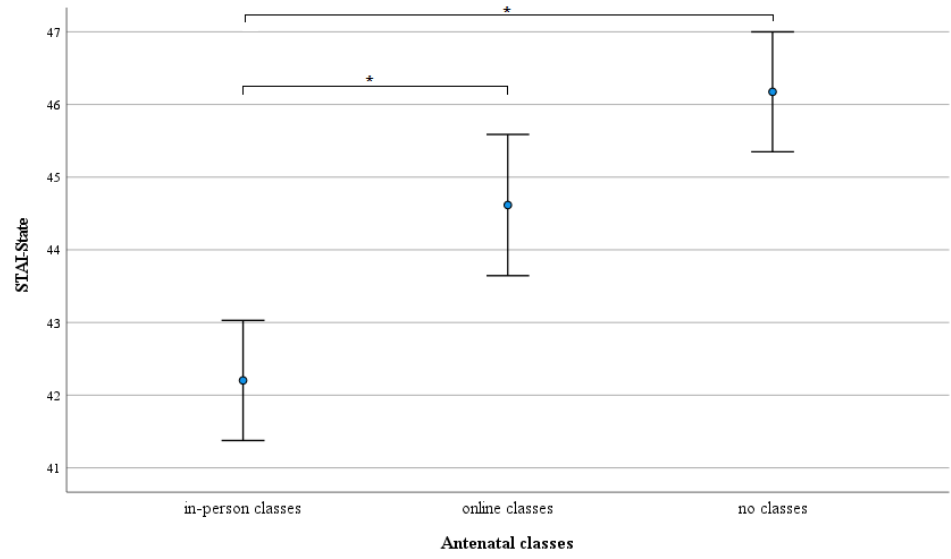
Figure 1. Differences in mean levels of state anxiety (dots) between in-person antenatal classes participants, online antenatal classes participants, and non-participants of any kind of antenatal classes adjusted for maternal age, pregnancy complications, COVID-19 infection, and STAI-Trait. Whiskers show 95% CI, * p < 0.05.